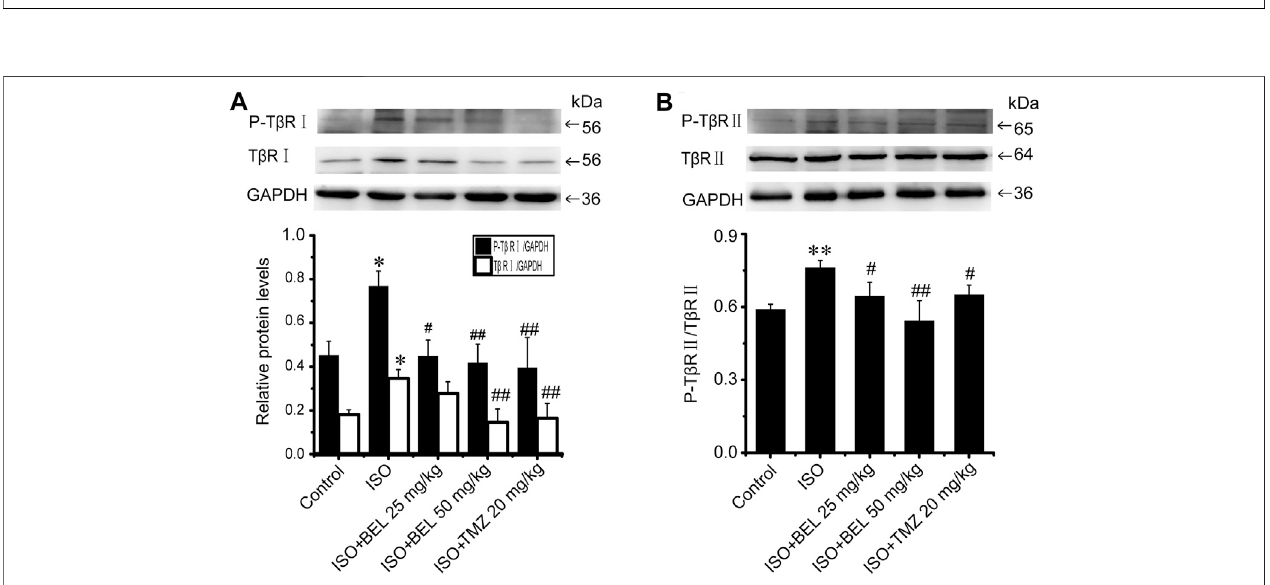
FIGURE6| BELlimitstheexpressionofT β RIandthephosphorylationofT β RIandIIinducedbyISO (AandB) WesternblottinganalysisofT β RII,P-T β RII,T β RI,and P-T β RI.BargraphsshowfoldchangesofP-T β RI/GAPDH,T β RI/GAPDHandP-T β RII/T β RII( n (cid:2) 3).Datawereshownasmean ± SEM.* p < 0.05vs.control,** p < 0.01vs. control, # p < 0.05 vs. ISO, ## p < 0.01 vs. ISO.